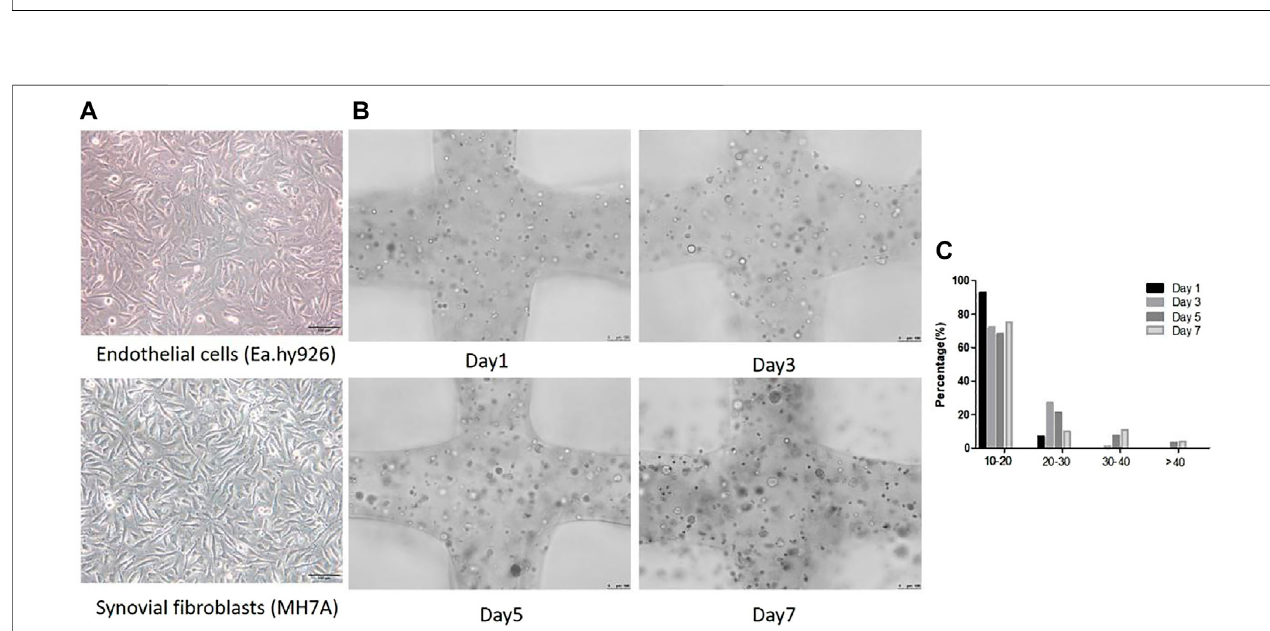
FIGURE4| Cellular morphological differences between2D planar culture and 3D scaffolds. (A) EA.hy 926 and MH7Acells morphology in2D planar culture. EA.hy 926 cells look epithelioid and MH7A cells are epithelioid and polygonal. Scale bar, 100 μ m. (B) 3D Gelatin /alginate/EA.hy 926/MH7A scaffolds observed by a fl uorescencemicroscopeonculturedays1,3,5,and7.Scalebar,100 μ m.Blackarrowsindicatecellsandcellularspheroidsin3Dscaffolds. (C) Distributionofspheroid diameter in 3D cell laden scaffolds on day 1, 3, 5, and 7.